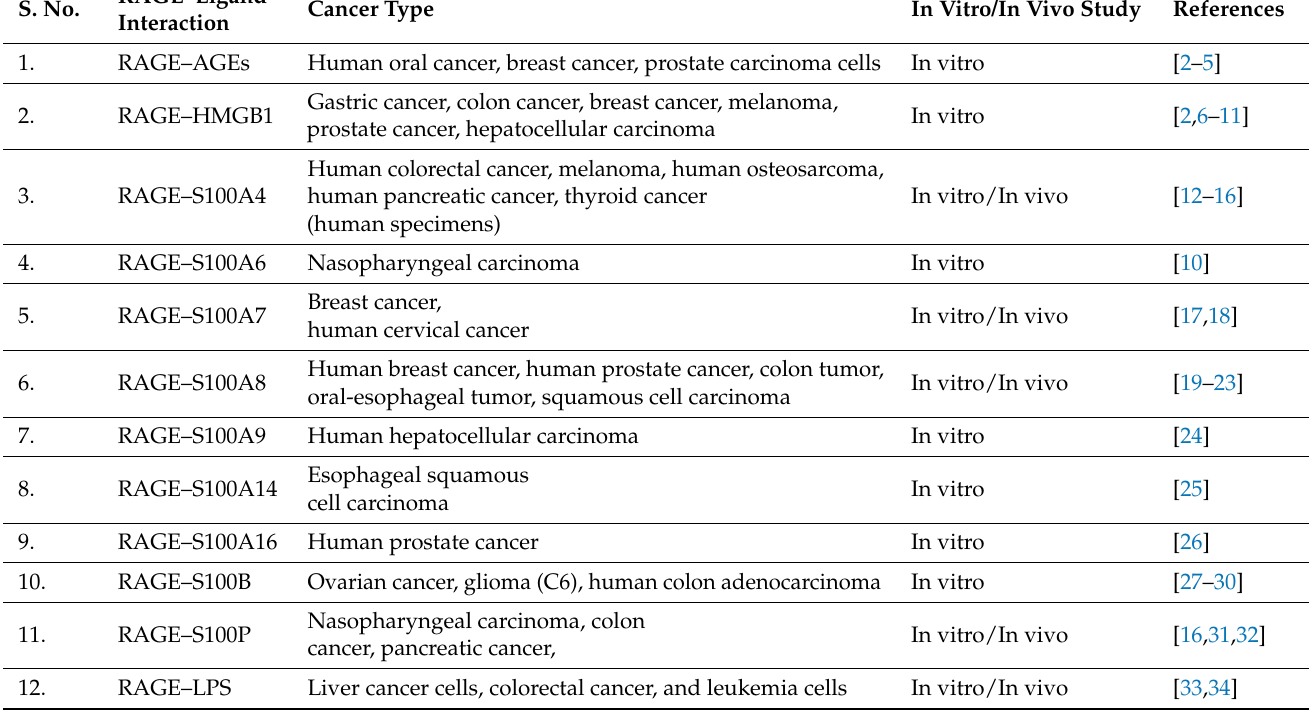
Table 1. RAGE–ligand interaction in different